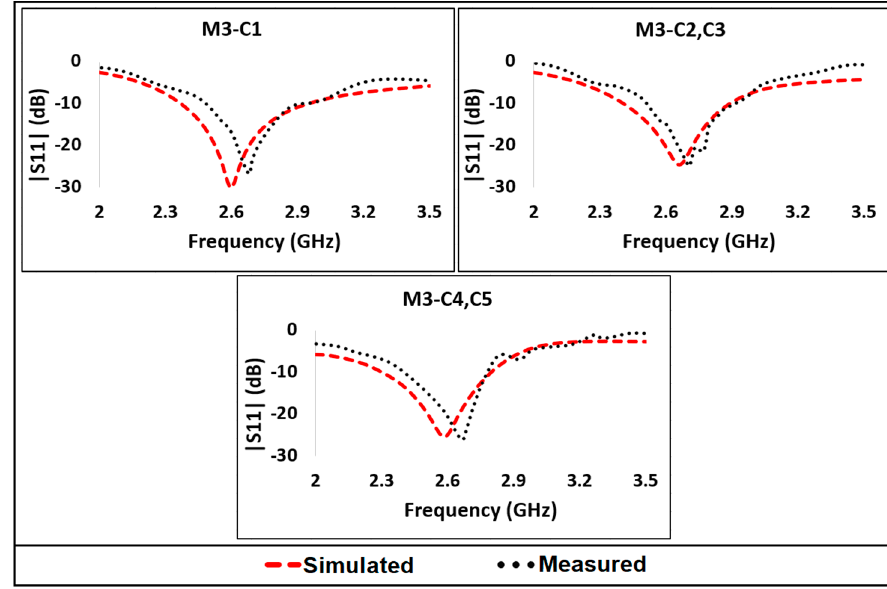
Figure 8. Measured vs Simulated |S11| for Cases of Mode 3.